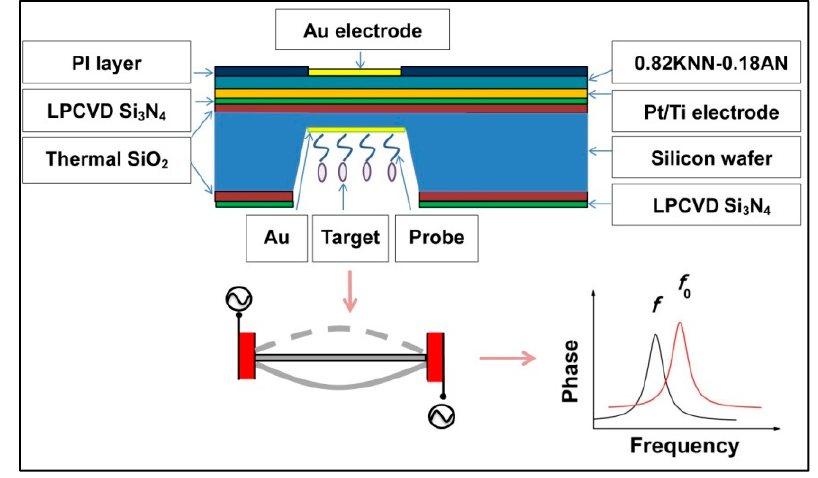
Figure 9. Schematic drawings and principle of the piezoelectric diaphragm biosensor.